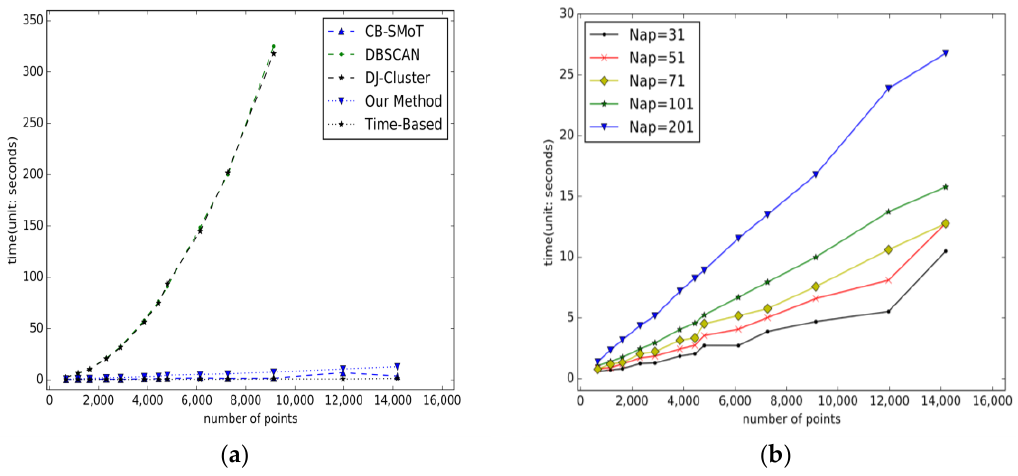
Figure 10. The efficiency evaluation. ( a ) Efficiency comparison; ( b ) effect of parameter Nap on the efficiency of our method.